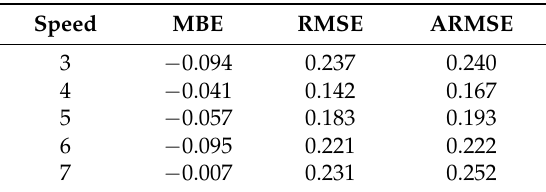
Table 5. Statistics of APV estimation for different treadmill speeds, in km/h (validation performed using the TW dataset).